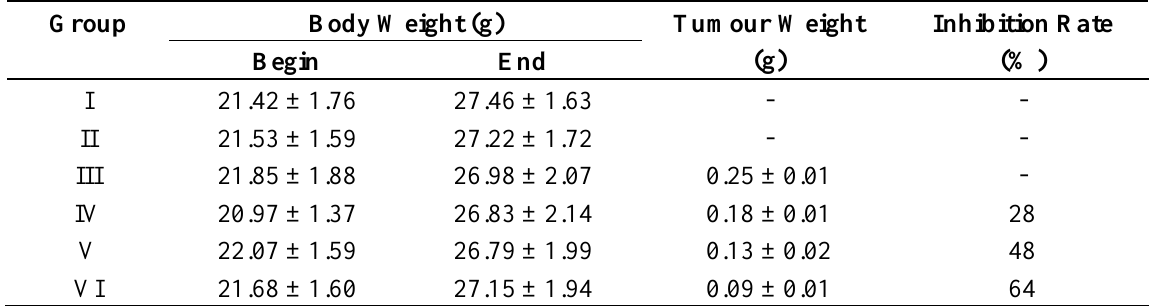
Table 2. Inhibitory effects on the tumor-bearing mice S180 model by tea polyphenol.